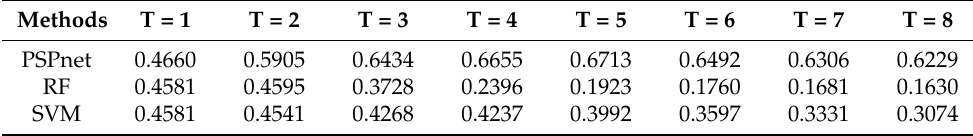
Table A7. The IoU of sample size S = 65 varies with the threshold level T.